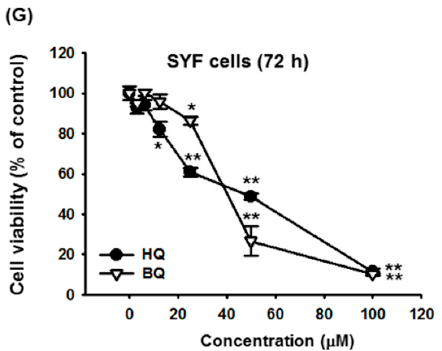
Figure 1. Effect of HQ on the proliferation of A431 and SYF cells. ( A ) Chemical structures of HQ and